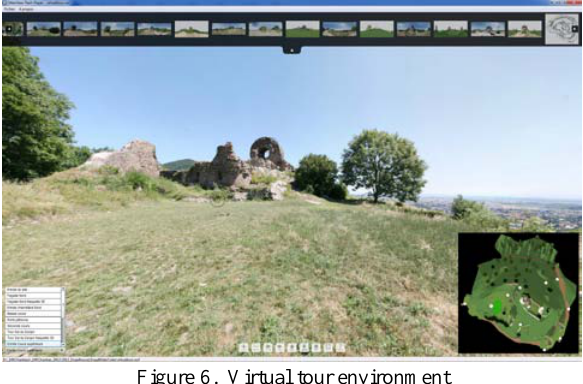
Figure 6. Virtual tour environment